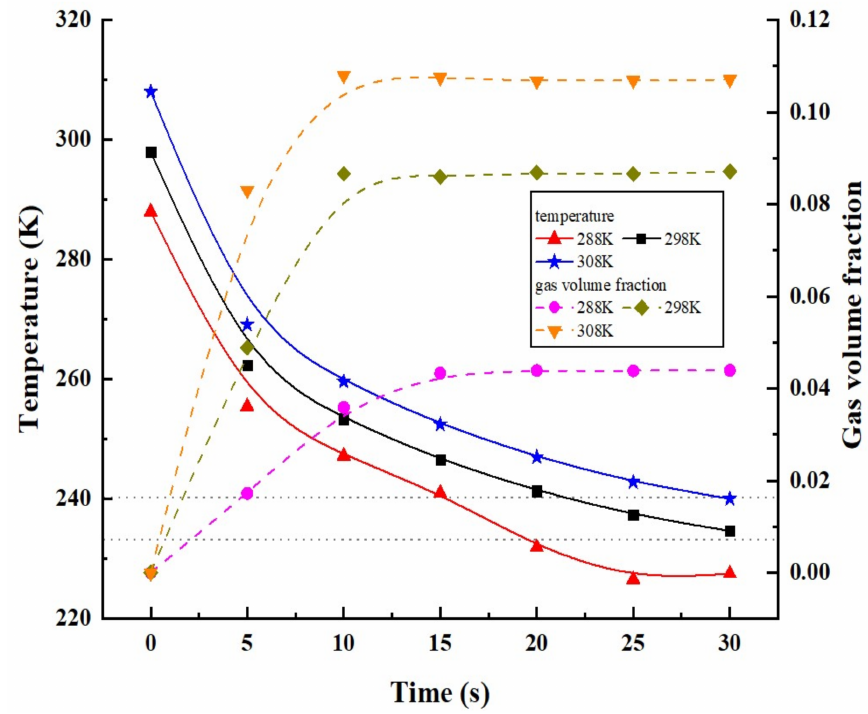
Figure 12. The influence of different hydrogen inlet temperatures on the pre-cooling temperature and R23 gas volume